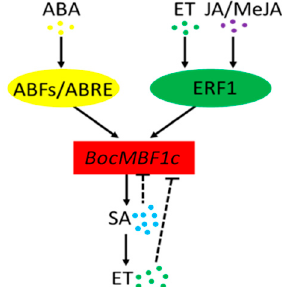
Figure 8. A model for the relation of BocMBF1c and other hormones. abscisic acid (ABA) and ethylene (ET) and jasmonic acid ( JA)/MeJA activate ABRE binding factors (ABFs)/ABRE and Ethylene response factor1 (ERF1), respectively. ABFs/ABRE and ERF1 then upregulate the BocMBF1c gene by interacting with cis-elements in the promoter region. The BocMBF1c protein can regulate the salicylic acid (SA) and ethylene (ET) heat stress responsive pathway. High concentrations of SA and ET will inhibit the expression of BocMBF1c through negative feedback.